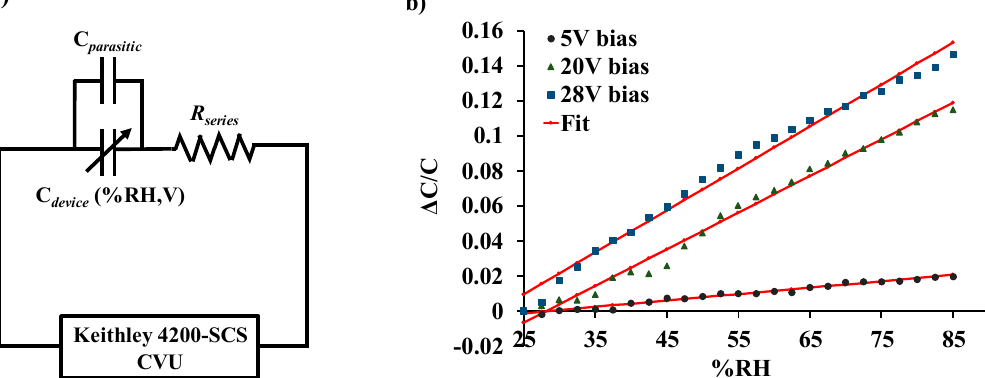
Figure 9. ( a ) Equivalent electrical representation of the LACM sensor. ( b ) Normalized change in capacitance of the sensor curve fitted to Equation (13).